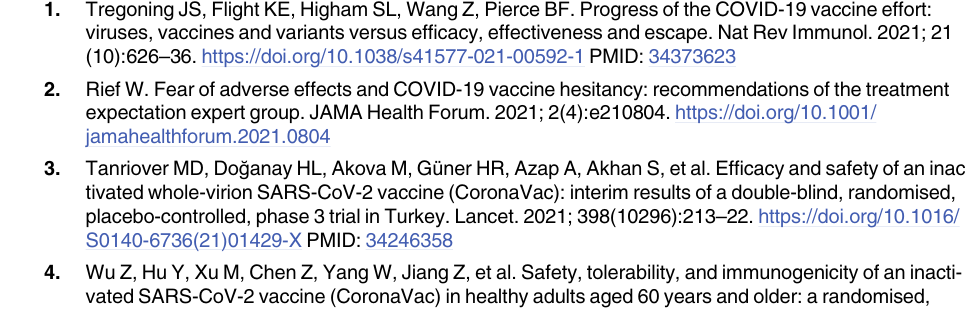
S3 Fig. Distribution of the occurrence of sleeping disturbance or disorder within 21 days after the first dose of